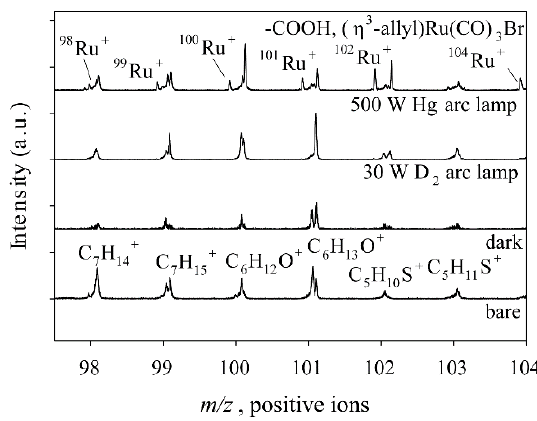
Figure 1. Secondary Ion Mass Spectra of the bare substrate surface relative to the surface when deposition is attempted in the absence of light, with a 30 W D 2 arc lamp, and with a 500 W Hg arc lamp. Deposition is performed onto carboxylic acid terminated self assembled monolayers built on a gold substrate.